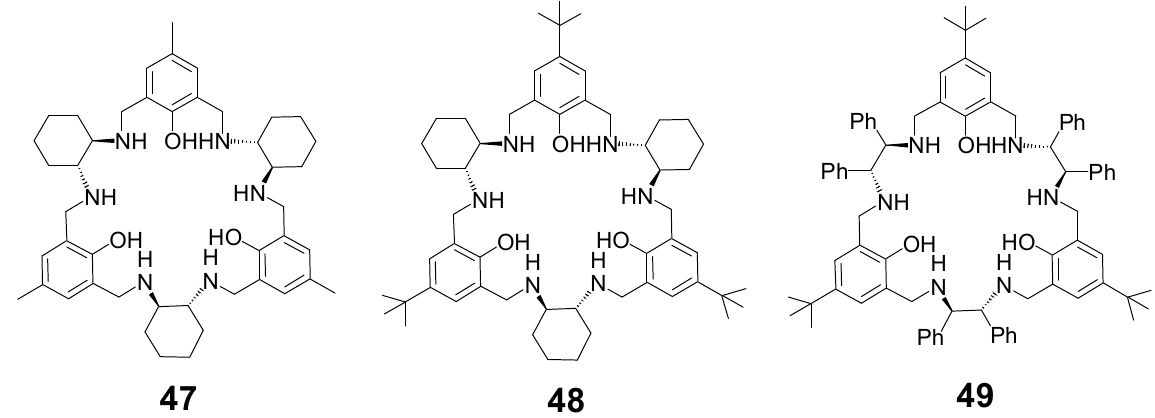
Figure 19. Metal-organic cage based on two macrocyclic units of 8 . Zinc atoms (violet) and ( S )- 2 - butanol are in spacefill representation.